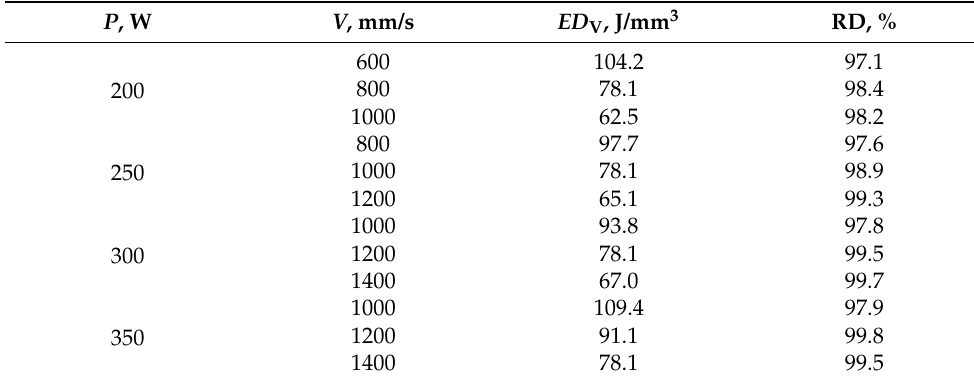
Table 1. LPBF process parameters and RD of the printed samples.